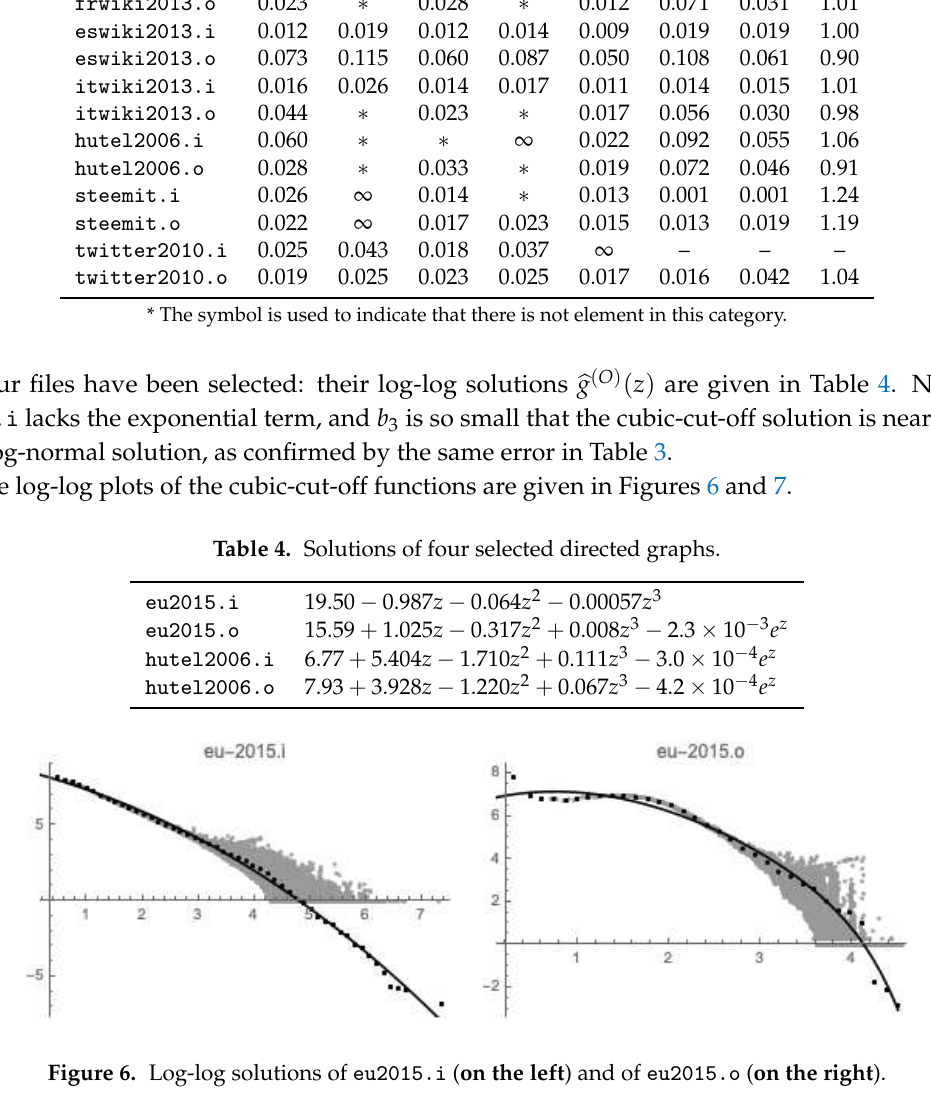
Figure 6. Log-log solutions of eu2015.i ( on the left ) and of eu2015.o ( on the right